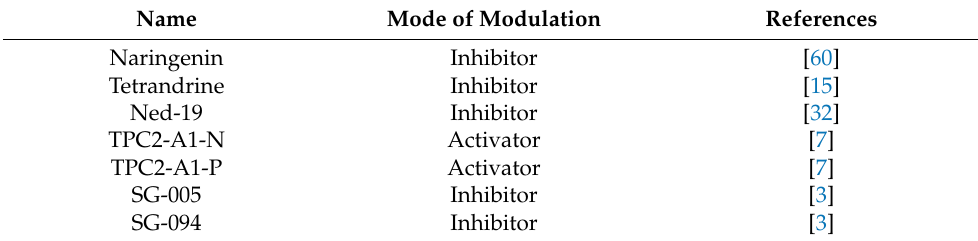
Table 1. Overview of the discussed pharmacological modulators in this review that act directly or indirectly on